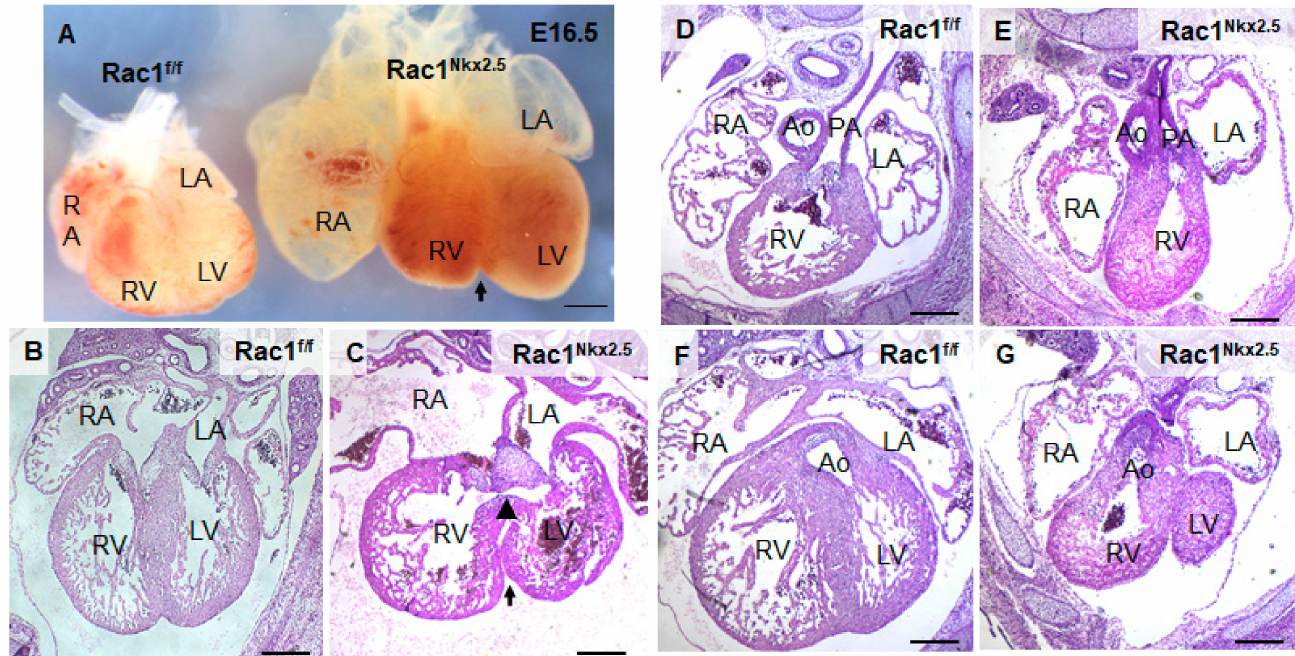
Figure 3. Congenital heart defects in Rac1 Nkx2.5 . ( A ) Bifid cardiac apex in an E16.5 Rac1 Nkx2.5 heart. Arrow indicates bifurcation between the RV and LV. ( B , C ) Ventricular septal defect (arrowhead) was found in E15.5 Rac1 Nkx2.5 hearts with an arrow indicating the bifid cardiac apex. ( D – G ) Double outlet right ventricle (DORV) was found in E15.5 Rac1 Nkx2.5 hearts. The pulmonary artery and aorta were connected to the RV and LV, respectively in Rac1 f/f control hearts ( D , F ). However, both pulmonary artery and aorta were connected to the RV in Rac1 Nkx2.5 hearts ( E , G ). RA, right atrium; LA, left atrium. Scale bars: 500 µ